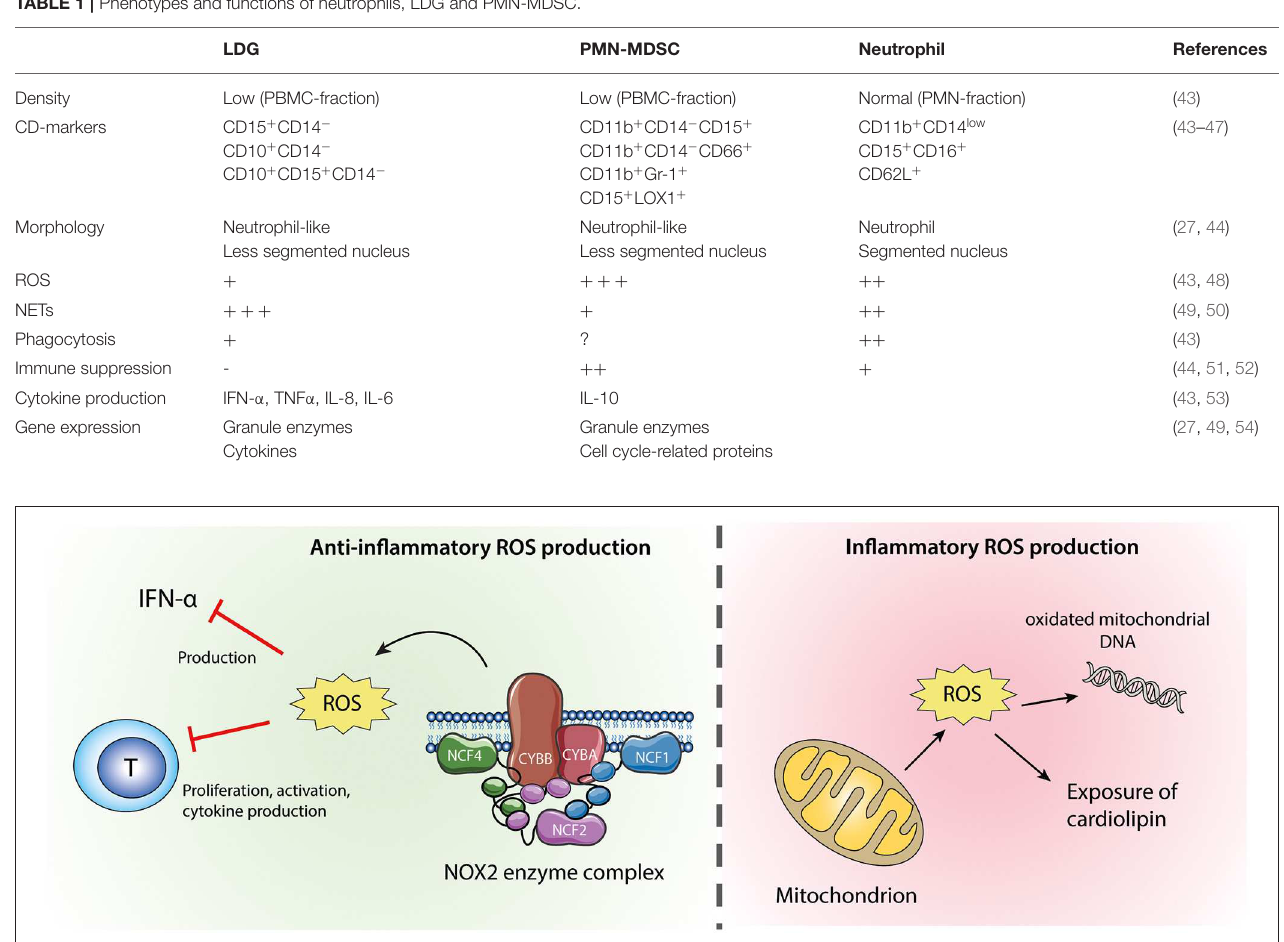
FIGURE 2 | Neutrophil ROS from NOX2 and mitochondria. ROS produced by the NOX2 enzyme complex (left) are anti-inflammatory via their inhibitory effects on IFN- α production and T-cell activation. Mitochondrial ROS (right) might cause oxidation of mitochondrial DNA which if released from the cell is highly inflammatory. Excessive mitochondrial ROS and apoptosis can also result in translocation of cardiolipin from the inner to the outer mitochondrial membrane and the plasma